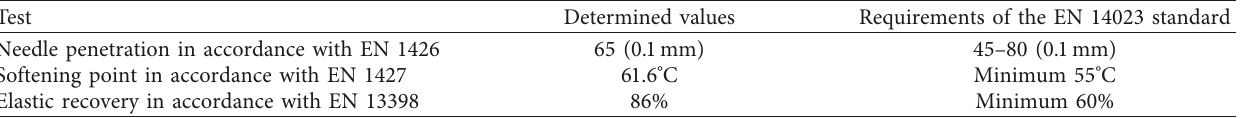
Table 1: Basic parameters of PMB 45/80-55.